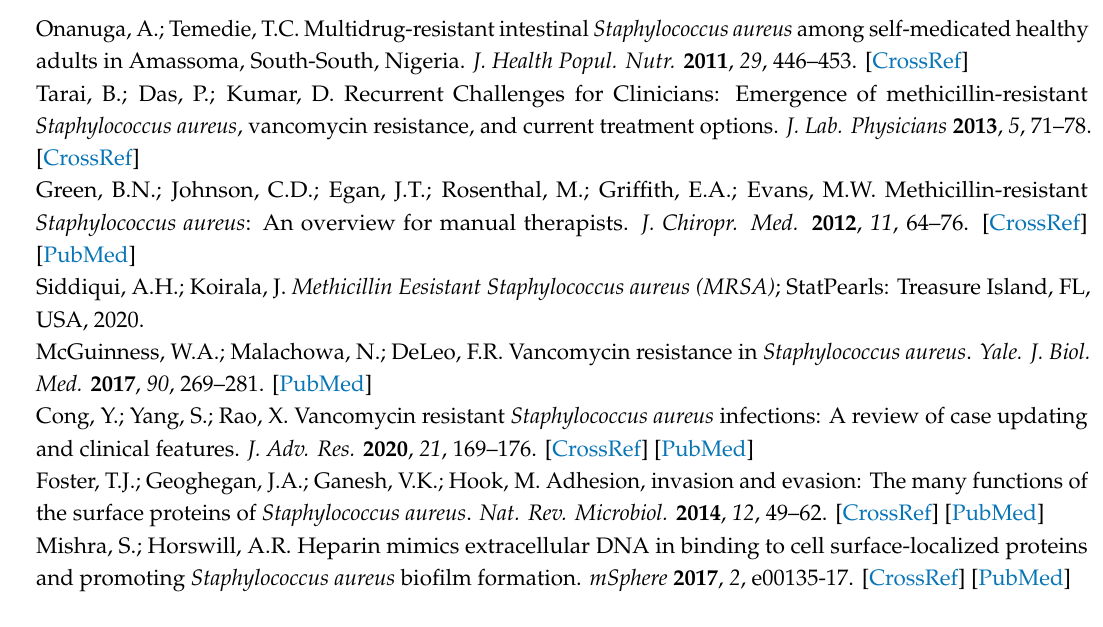
title, Table S1: The bacterial and fungal isolates used for the in vitro activity testing. Table S2: The in silico predictions of human proteins interacting with KTU-286. The in silico predictions were computed using SwissTargetPrediction